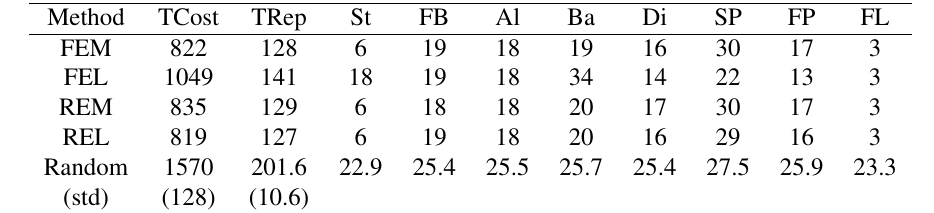
Table 4. DAP-TR results when threshold is